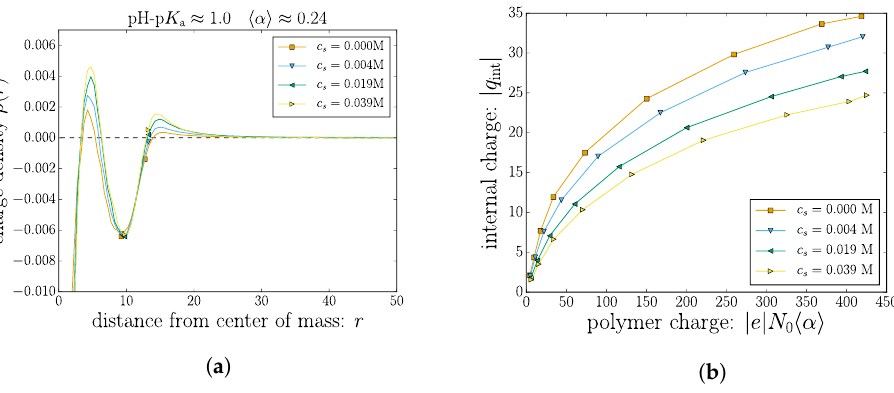
Figure 6. (Color online) ( a ) For the selected case corresponding to (cid:104) α (cid:105) ≈ 0.24, the total charge density is plotted as a function of the radial distance to the nanogel center of mass. The symbols mark (in ascending order) the value of R H and critical radial position r ∗ at which 100% of the nanogel monomers are included. ( b ) The integrated net charge of the nanogel complex (up to r ∗ ) as a function of pH-p K a